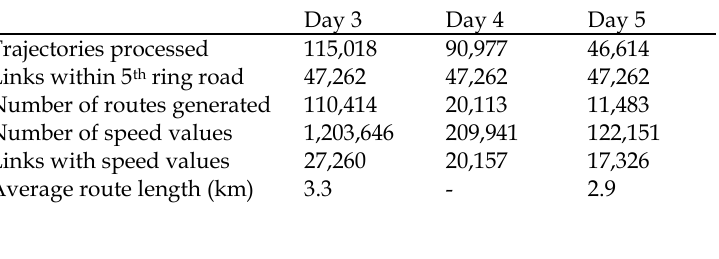
Table 3. The results of path